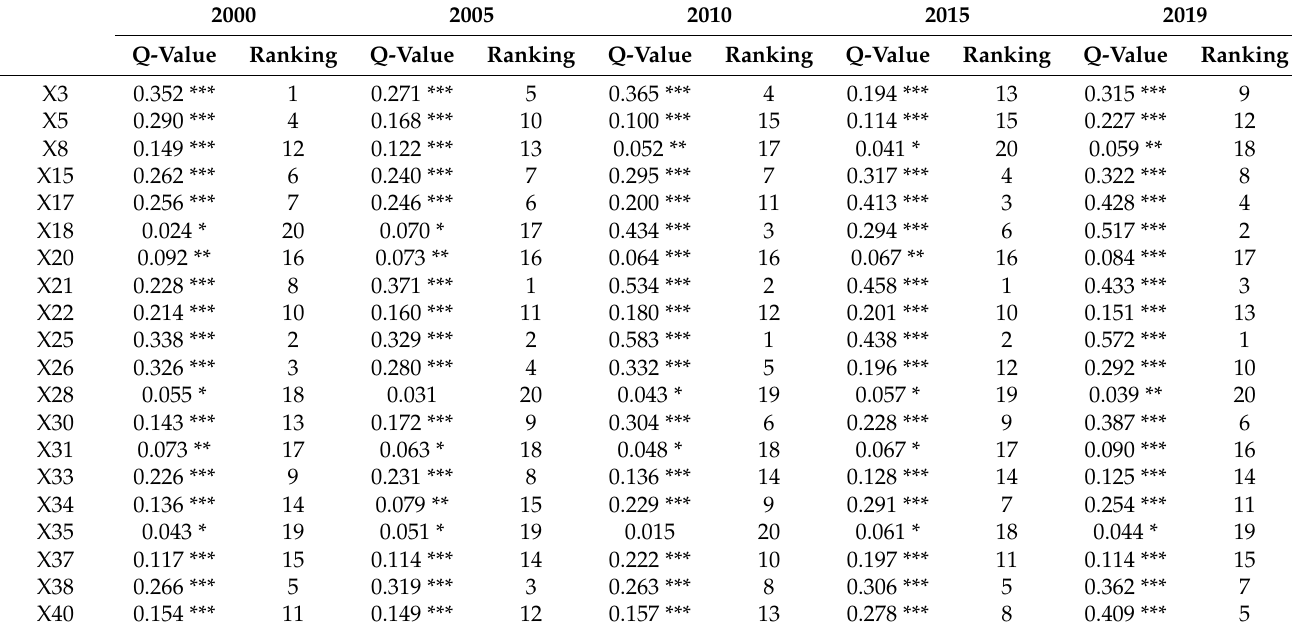
Table 5. The determining power of driving factors of the sustainable development level of urban human settlements in